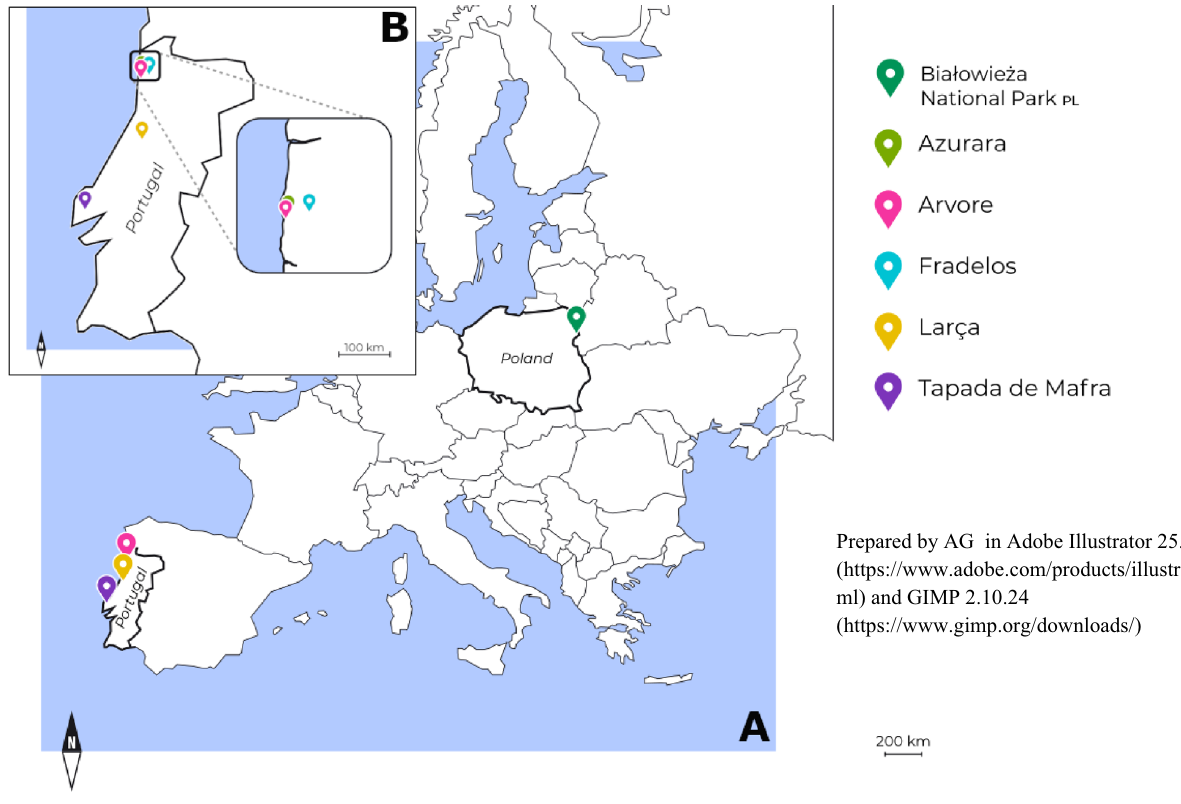
Figure 1. Study area in Poland and Portugal ( A ). Figure ( B ) shows five places where robins were caught to collect